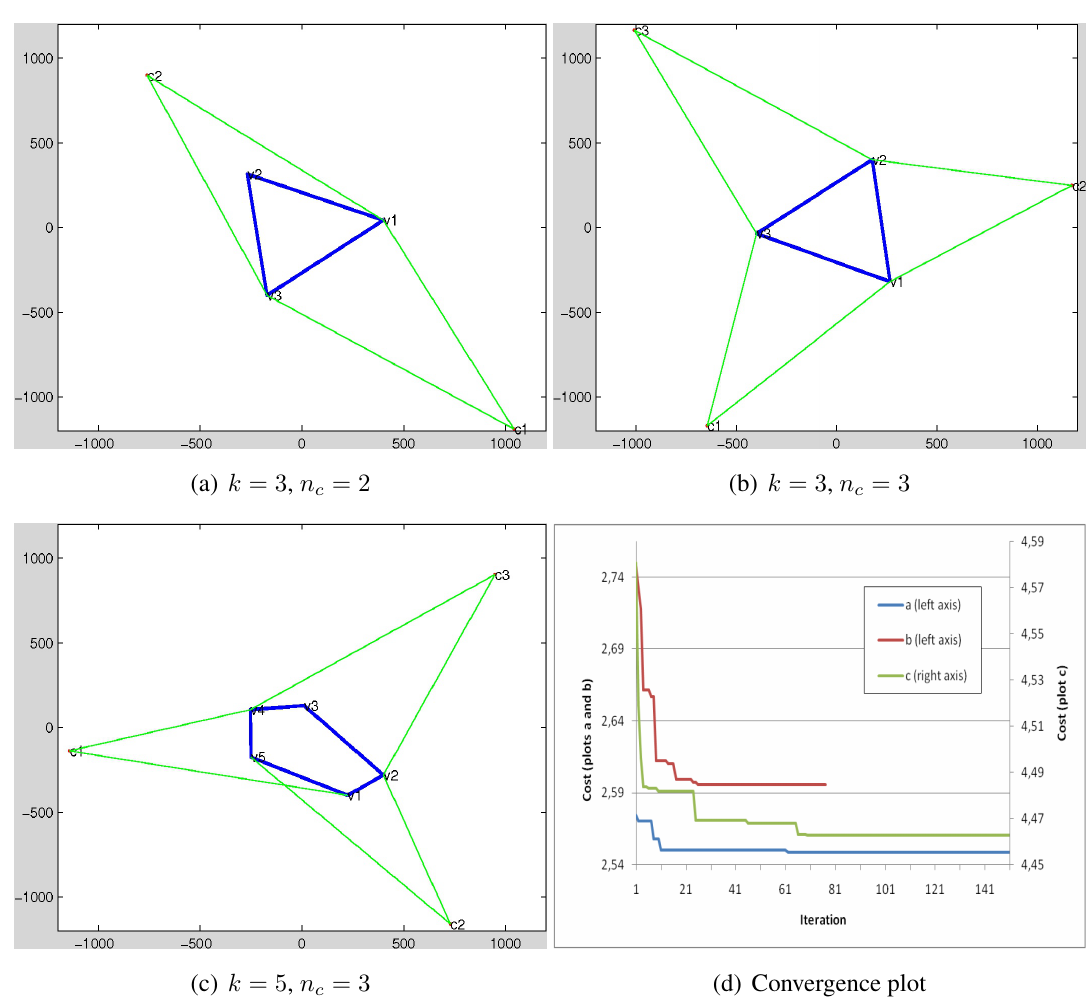
Figure 6. Results for camera placement optimization using the proposed GA. ( a – c ) depict three different samples. In each sample, a polygon with k vertices is randomly generated and the purpose of the algorithm is to search for an optimal coverage using n cameras. The convergences for the samples are plotted in ( d ). The vertical axis depicts the cost value for the fittest chromosome in each iteration, once it gets divided into the number of genes ( n ). The dimension of the search space is 1200 × 1200 cm 2 c